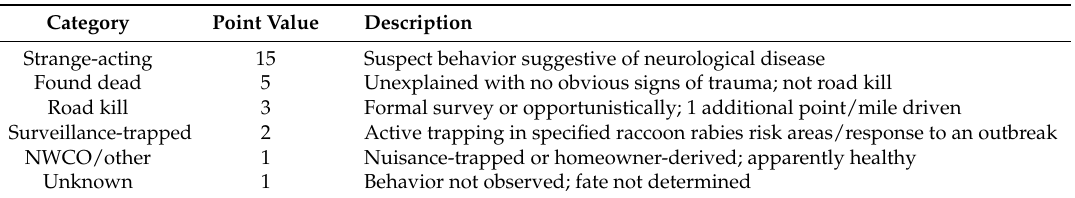
Table 2. Six standardized sample categories and associated stratified point values (i.e., weights) for enhanced rabies